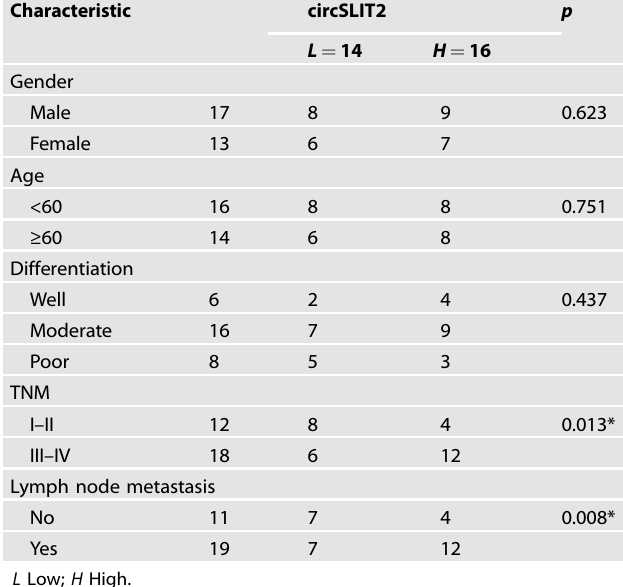
Table 1. Relationship between circSLIT2 and PDAC patients ’ clinicopathological